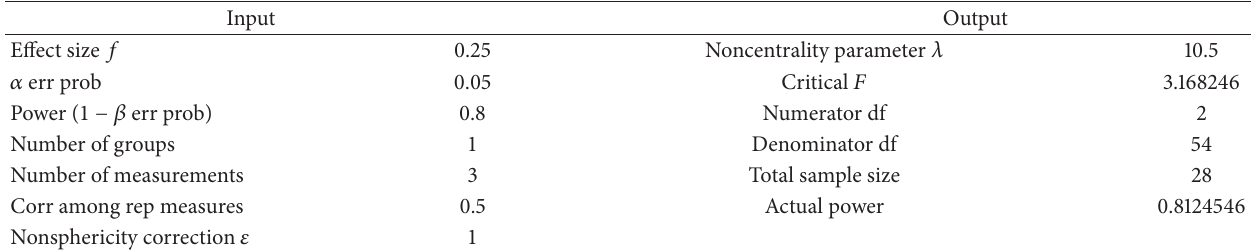
Figure 4: Lower effect sizes lead to a necessary increase of sample size to achieve the same minimum power. Estimated sample size from a literature analysis is of at least 28 participants. Table 2: A priori analysis to compute the required sample size in a repeated measures